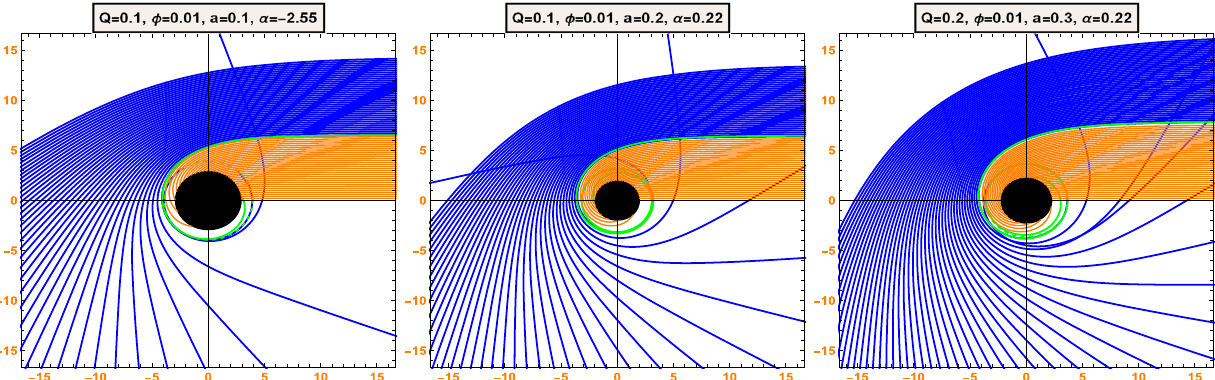
Fig. 2 Thetrajectoriesofphotonringsfordifferentparametersinpolar coordinates ( r ,ϕ) . The considering BH is shown as solid black disks, and the blue, green and orange lines correspond to b > b c , b = b c